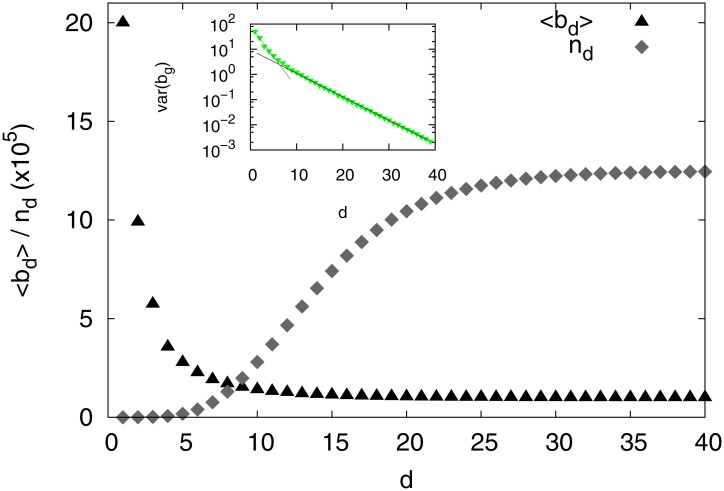
Average branching ratio, 〈bd〉 and number of different game-linesnd as function of the depth level d in the database.Inset: variance of the distribution of branches per node bg as function of the depth d and linear fit of the two exponential regimes.